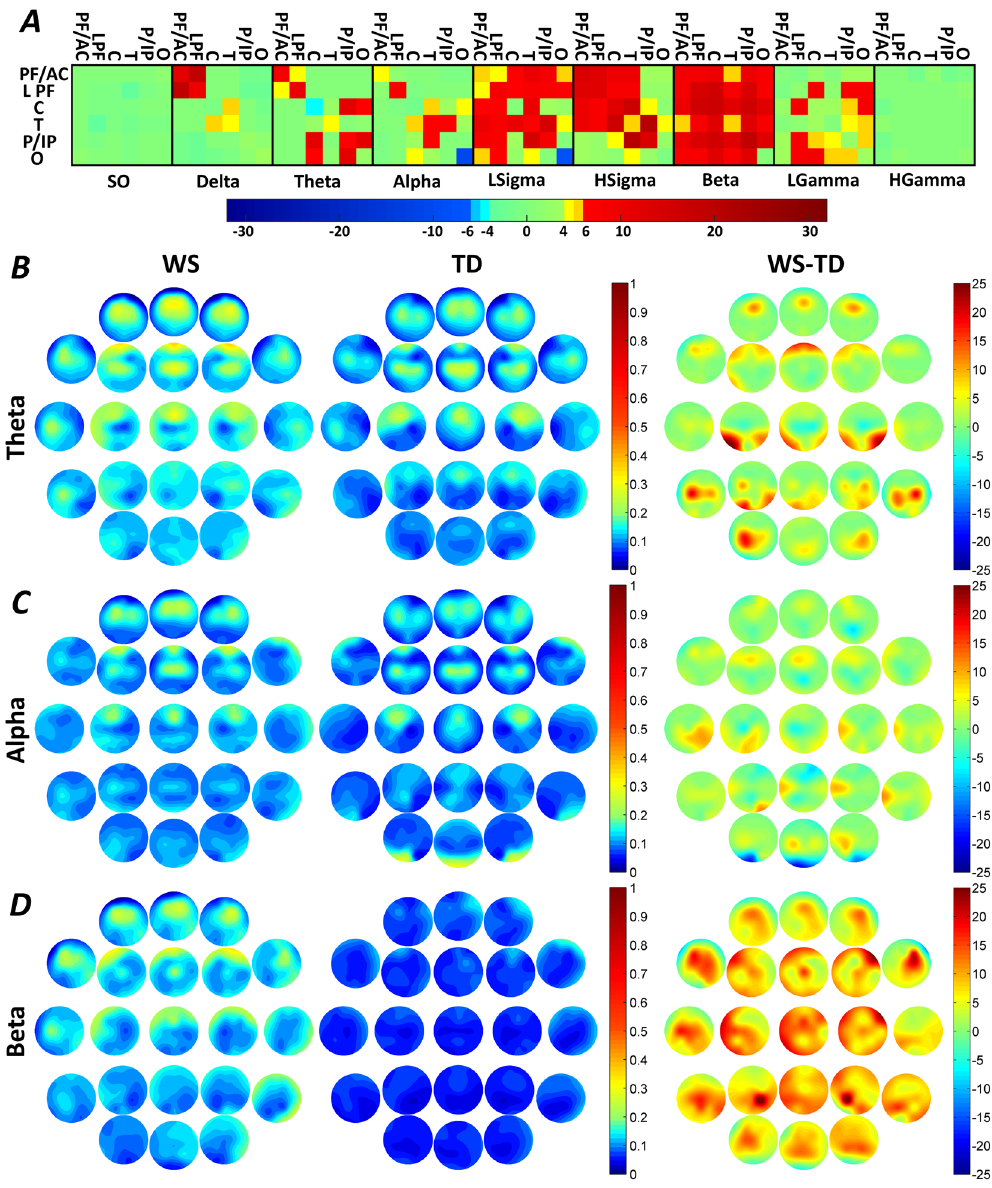
Figure 6. Region-specific and band-limited REM sleep EEG connectivity differences. Frequency range codes: SO = Slow oscillation, LSigma = Low sigma, HSigma = High sigma, LGamma = Low gamma, HGamma = High gamma. Color codes: Red = Williams syndrome > typically developing (B-H corrected), Yellow-orange = Williams syndrome > typically developing (uncorrected), Green = Williams syndrome ≈ typically developing, Light blue = Williams syndrome < typically developing (uncorrected), Blue = Williams syndrome < typically developing (B-H corrected). B-D. Theta, alpha and beta WPLI maps highlighting the patterns of absolute group means (left: Williams syndrome; middle: typically developing) and Williams syndrome-typically developing differences (right). Positions of the maps represents the seed derivation of the synchronization analyses (according to the 10–20 system), while the color patterns are the representations of the variable strengths in the synchronization (WPLI) between the respective region and the seed